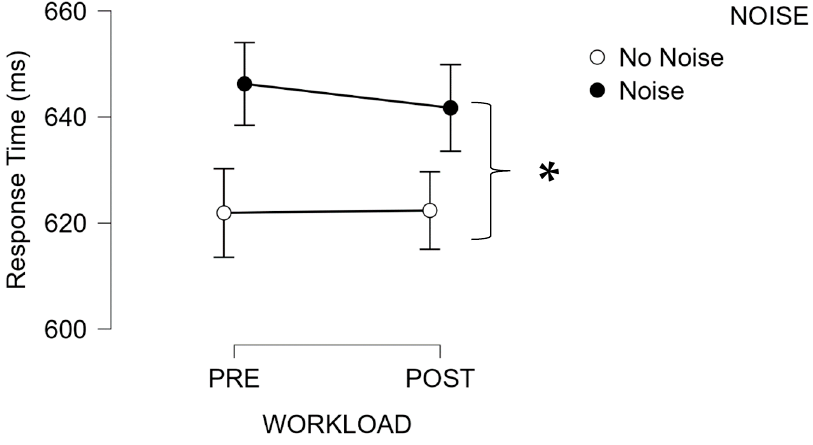
Figure 4. Response times (ms) during a simple response time (SRT) task, without (No Noise) and with noise (Noise), before (PRE) and after (POST) the workload. * represents significant difference at p < 0.05, and bars represent standard errors.